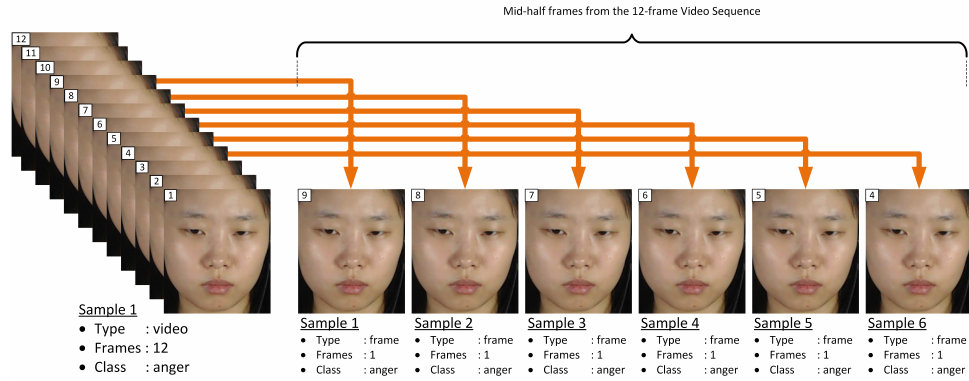
Figure 6. Illustration of video to frame sampling for Experiment III.